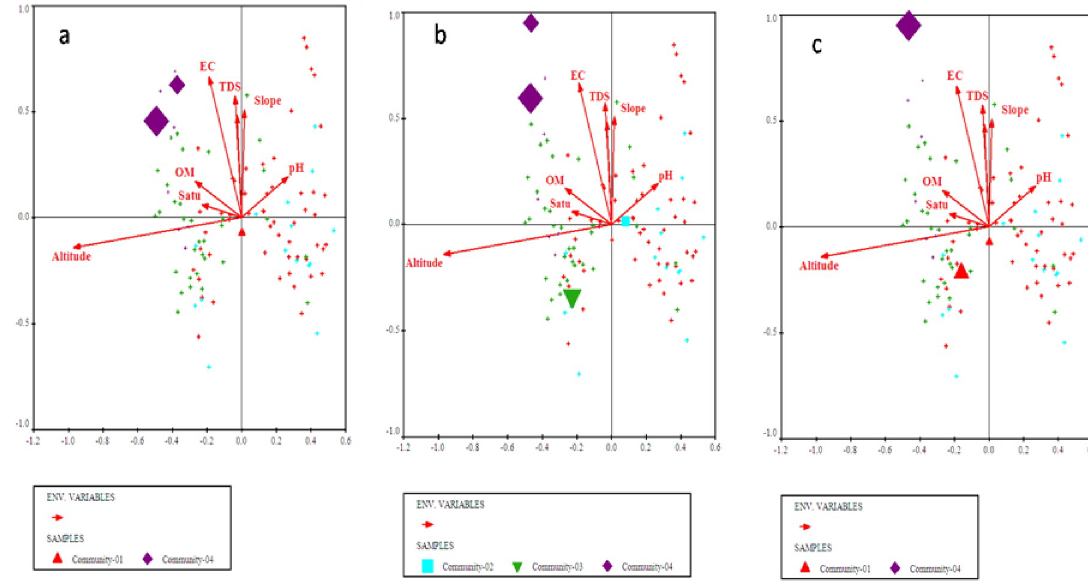
Fig 6. Bi-plot of Alnus nitida , Myrsine africana and Ranunculus arvensis with measured environmental variables after CCA of CANOCO software.